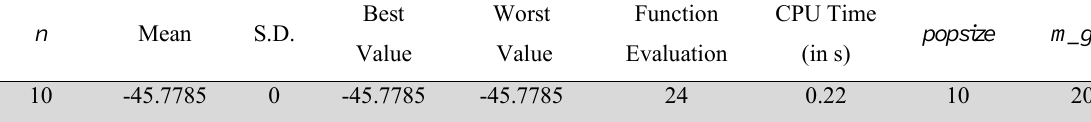
Computational Results of Problem -12